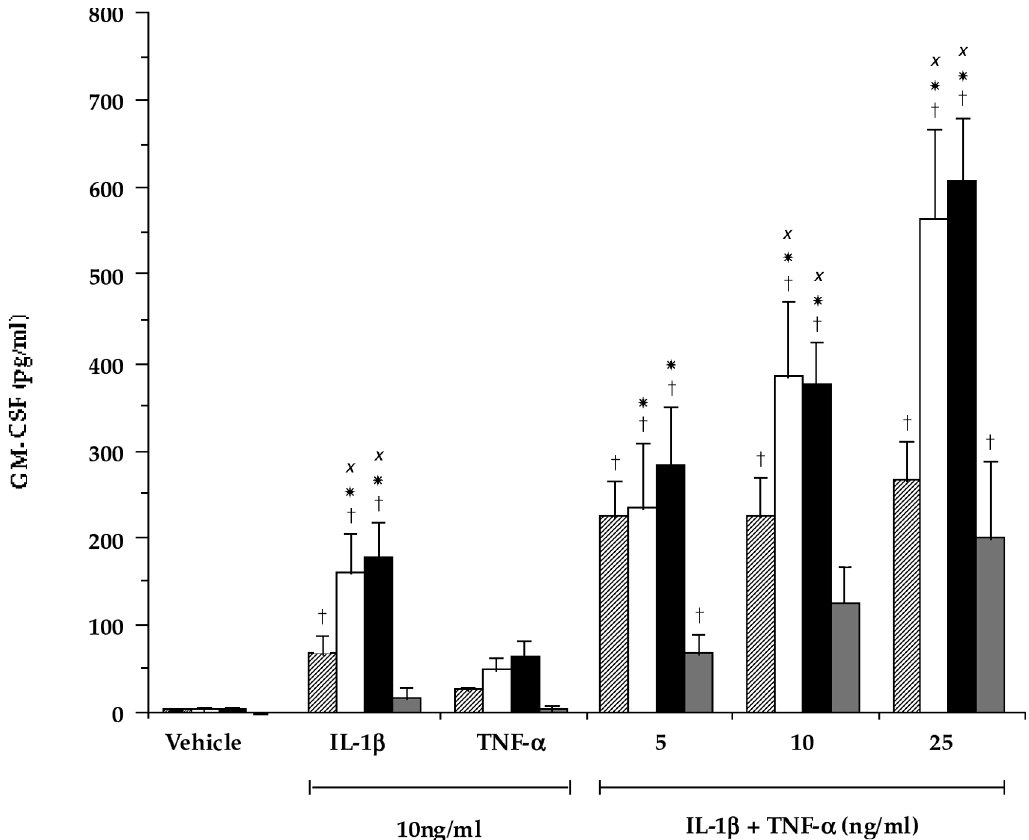
FIG. 4. GM-CSF release by human airway smooth muscle cells stimulated with IL–1 b /TNF- a or vehicle for 24h only (striped bars) or stimulated with IL–1 b /TNF- a or vehicle for 24h and subsequently exposed to either allergic asthmatic serum (AAS) (white bars), non-allergic non-asthmatic serum (NAS) (black bars) or Monomed™ (a defined serum substitute) (grey bars) for 24h (Table 1: protocol 3). Bars represent means±SEM from four to seven cell donors. † p £ 0.05 compared with cytokine vehicle control. * p £ 0.05 compared with Monomed™ control (grey bars). x p £ 0.05 compared with cells stimulated with IL–1 b and TNF- a only (striped